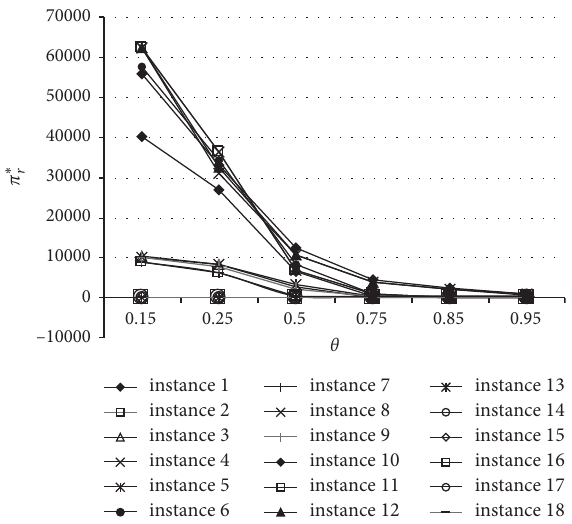
Figure 4: Retailer’ profit in the decentralized dual-channel supply chain for different